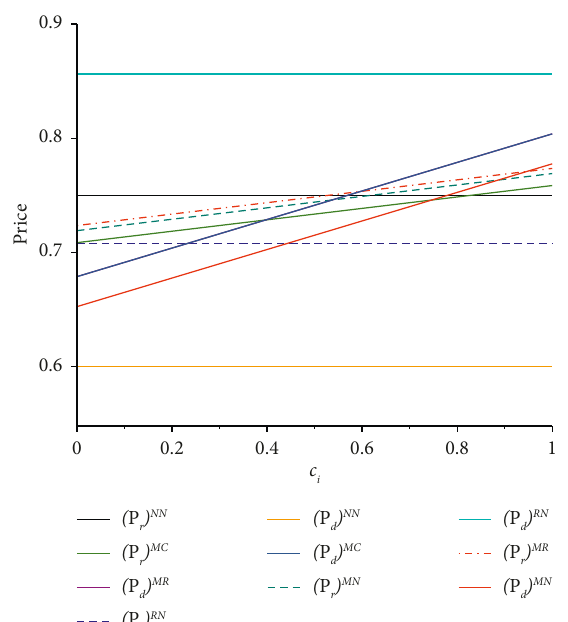
Figure 7: Effect of r on optimal